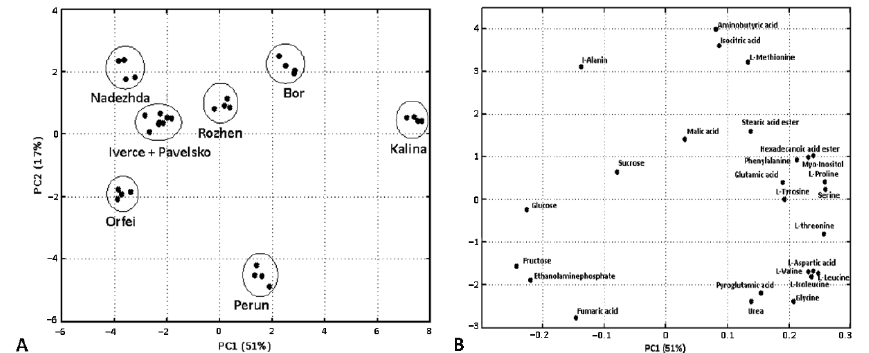
Figure 2. Principal component analysis of identified metabolites in different potato tubers. ( A ) PCA score plot. The replicates from each potato cultivar are represented with circlets. ( B ) PCA loading plot. The identified and quantified metabolites in each potato cultivar are represented with circlets.